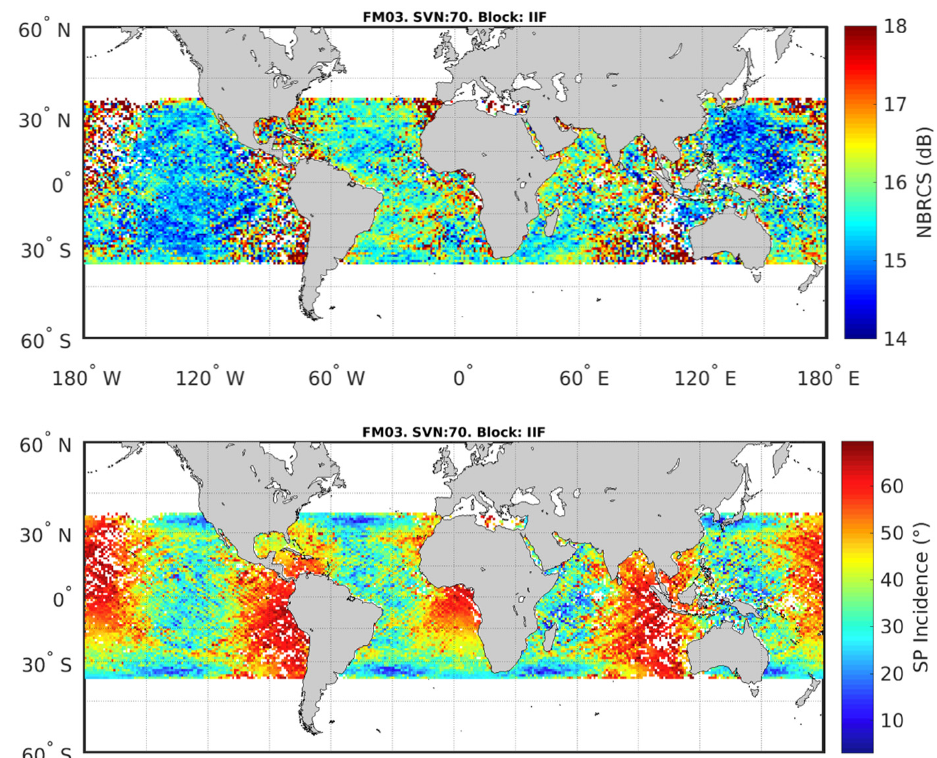
Figure 3. ( top ) Geographical distribution of NBRCS reported by CyGNSS FM03 for signals incoming from GPS SVN70 (Block IIF) for U10 ~7 m/s. ( bottom ) Corresponding geographical distribution of incidence angle between CyGNSS FM03 and GPS SVN70 (Block IIF).